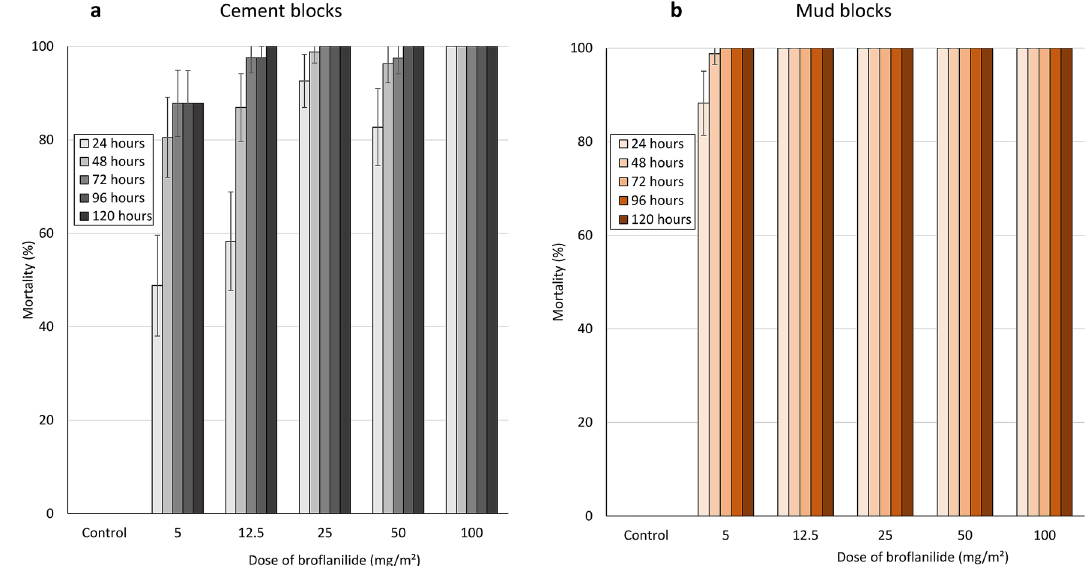
Figure 2. Mortality of insecticide-susceptible An. gambiae ss Kisumu strain mosquitoes on broflanilide WP treated cement ( a ) and mud ( b ) blocks substrates. Mosquitoes were exposed 1-week post-treatment for 30-min in WHO cone bioassays and mortality recorded every 24 h for up to 120